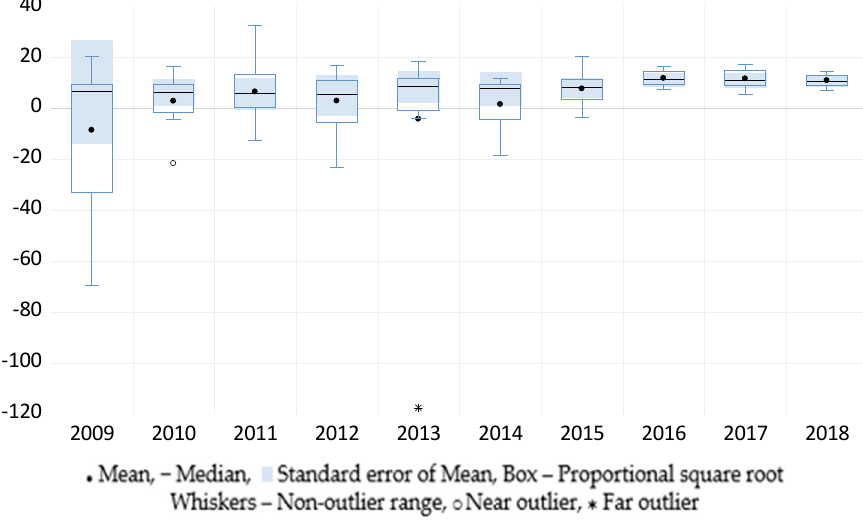
Figure 2. Boxplot of ROE in CEE countries, 1995–2018 (%). Unlike ROA and ROE, which displayed both negative and positive values over time, NIMs have remained positive between 2009 and 2018 for all countries in our sample, sug- gesting a strong core performance of the CEE banking systems. Although mean and me- dian NIM, respectively, have shown low variation across years, there were important dis- crepancies between countries, particularly in 2010 and 2009, when the differences between the maximum and minimum NIM was 4% and 3.7%, respectively. It is difficult to distin- guish specific trends in NIM evolution for several years, which is quite different from ROA and ROE patterns, and we also note the quite important relative variation of NIM among CEE countries for each year, without a specific trend towards homogeneity as one moves towards 2018.